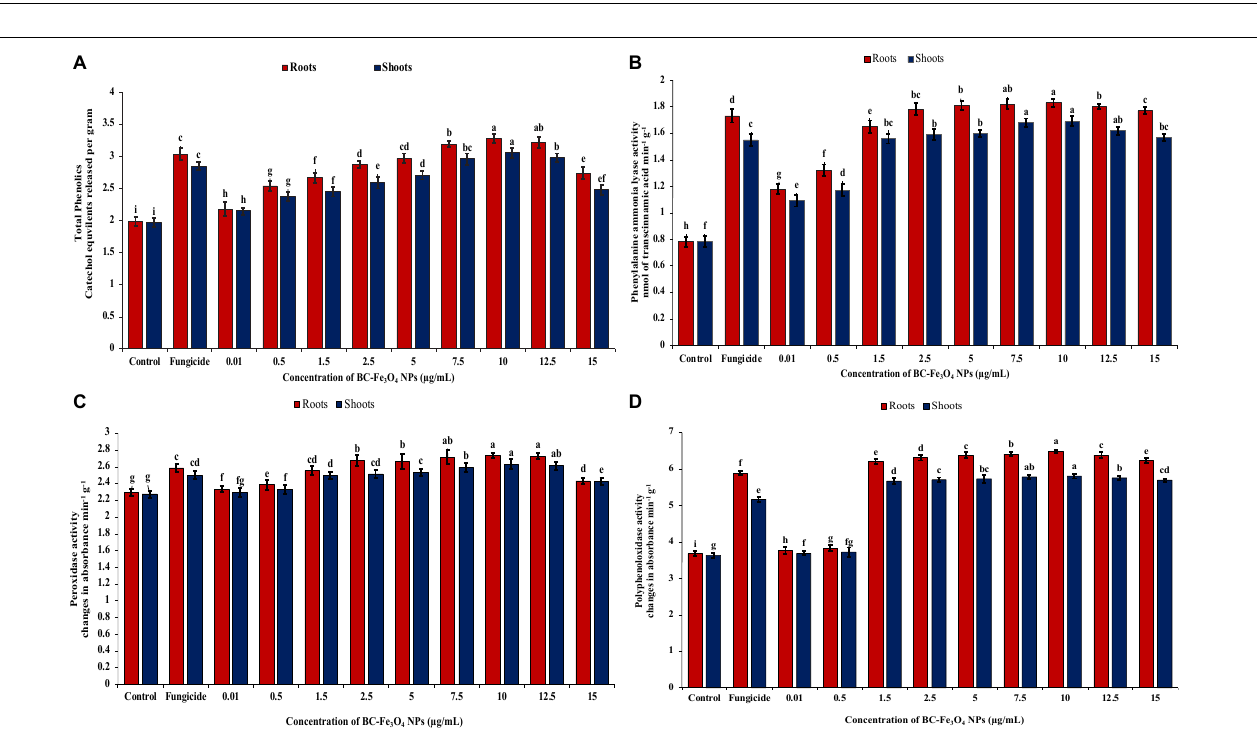
FIGURE 13 | Effect of various concentrations of Fe 3 O 4 NPs on plant height, root and shoot, and length infected with Fusarium wilt under greenhouse conditions. Vertical bars represent SD ( n = 3) between the mean of different replicates of the same treatment. Different letters per column indicate significant differences among treatments, determined by ANOVA and LSD tests at P ≤ 0.05.